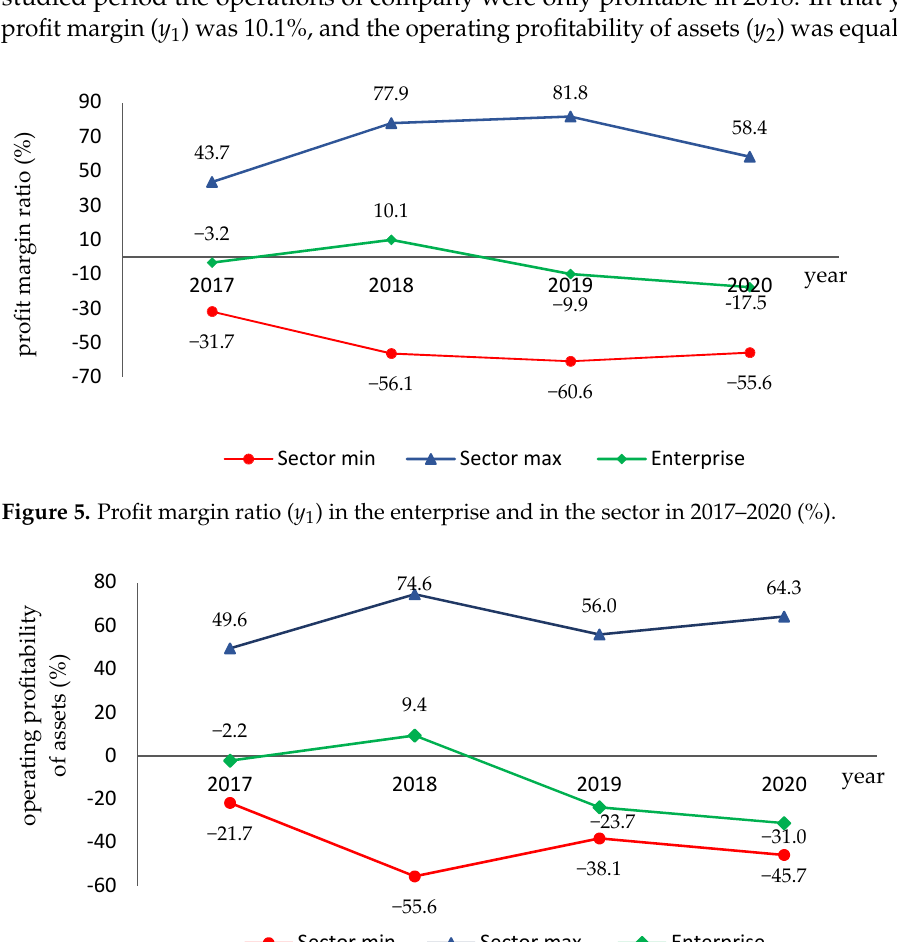
Figure 6. Operating profitability of assets ( y 2 ) in the enterprise and in the sector in 2017–2020 (%). The obtained results, in comparison with the values achieved in the entire sector, indicate that the studied company achieved relatively low profitability in the year